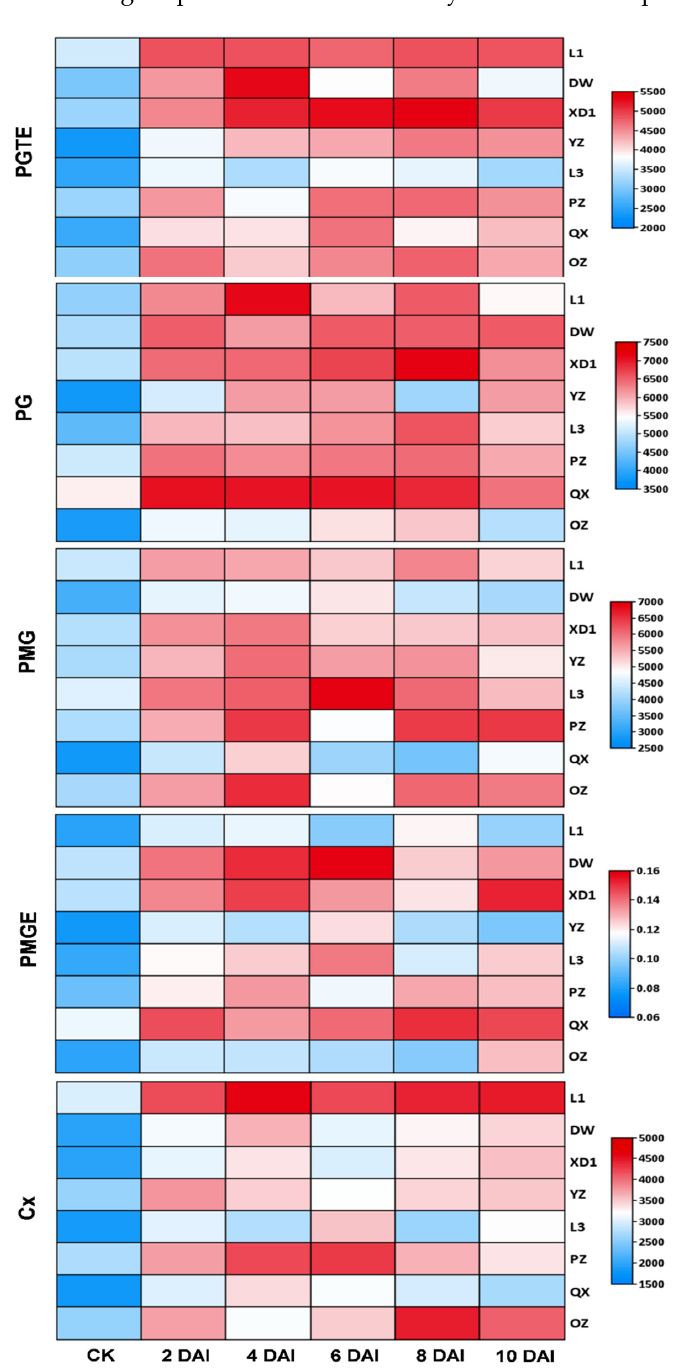
Figure 4. Cluster heat map of the cell wall degrading enzyme activity in eight hazel nut varieties (Liao 1 (L1), Dawei (DW), Xianda No. 1 (XD1), Yuzhui (YZ), Liao 3 (L3), Ping hazelnut (PZ), Qiuxiang (QX), European hazelnut (OZ)) on 2, 4, 6, 8 and 10 DAI of B. cinerea infection. Polygalacturonase trans elimination enzyme (PGTE), Polygalacturonase (PG), Pectin methyl galacturonase (PMG), Pectin methyl trans elimination enzyme (PMGE), Carboxymethyl cellulase (Cx).